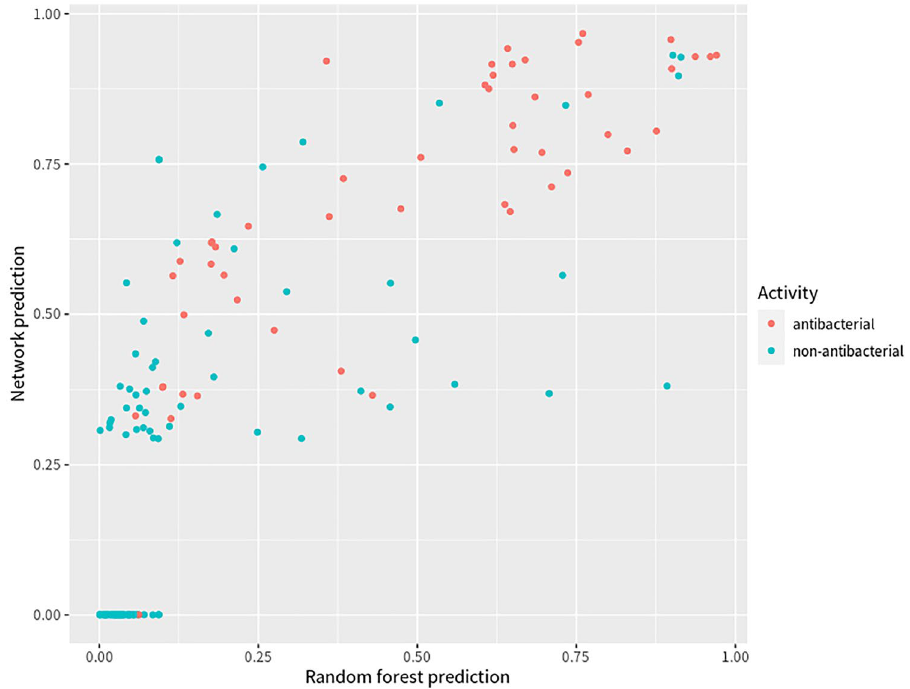
Figure 3. Plot of the prediction results by both models. Plot of the 162 molecules with empirically tested antibacterial information and also predicted with top and bottom scores respectively for antibacterial properties by Stokes’ model 10 . Blue dots represent non-antibacterials; orange dots represent antibacterials. X-axis (Pred_ Score_Forest) is the score predicted by our final model, a random forest classifier; Y-axis (Pred_Score_Net) is the score predicted by Stokes’ final model 10 , a graph neural